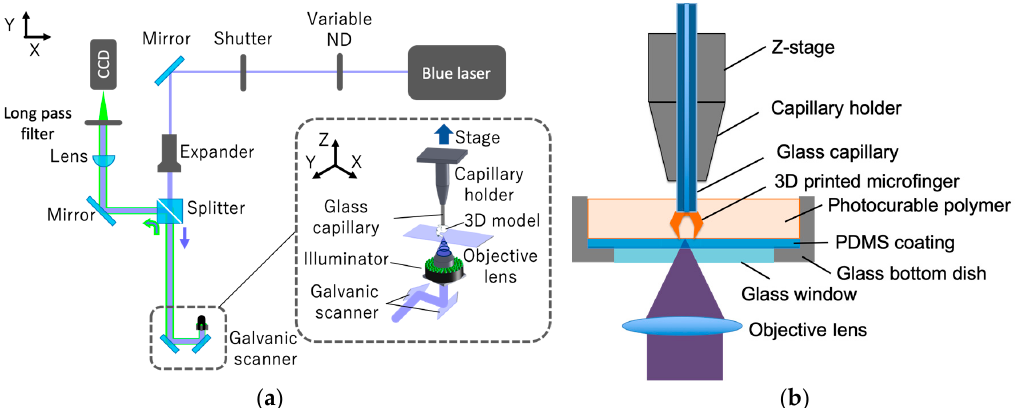
Figure 1. Microstereolithography system used to additively manufacture microfingers on top of a glass capillary: ( a ) Optical system; ( b ) Setup for fabricating microfingers at the end of a glass capillary.